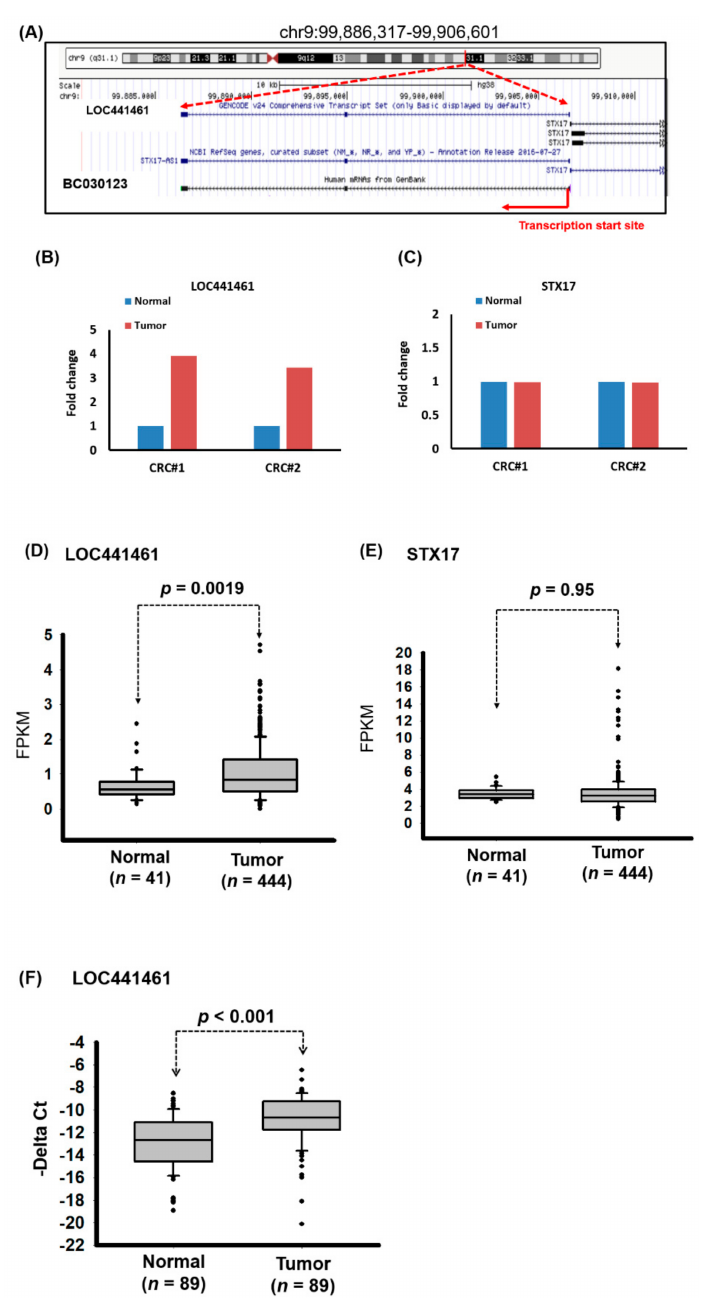
Figure 1. Abnormal expression of LOC441461 in human colorectal carcinoma (CRC). ( A ) Schematic representation of the location of LOC441461 in the human genome, as obtained from the website of the University of California, Santa Cruz (https: // genome.ucsc.edu / ). ( B , C ) Expression levels of LOC441461 and STX17 in the CRC samples and adjacent normal samples of two patients were determined using a microarray approach. ( D , E ) Expression levels of LOC441461 and STX17 were examined in human colorectal cancer samples obtained from The Cancer Genome Atlas (TCGA) database. Fragments per kilobase of transcripts per million was used to quantify the gene expression. ( F ) Expression levels of LOC441461 were examined using real-time (RT)-polymerase chain reaction (PCR) in CRC tissues and the corresponding normal tissues from 89 patients. The LOC441461 expression levels were statistically analyzed using Student’s t test. The di ff erence was considered significant when p <